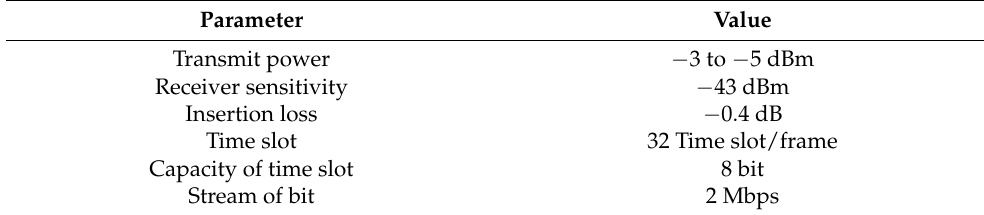
Table 2. The parameters of implemented FPMT technique.